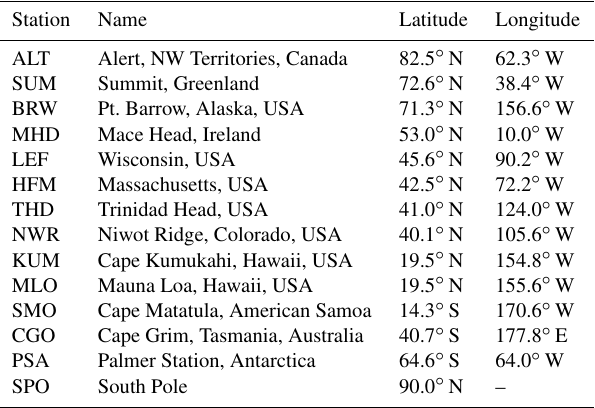
Table 2. Location and code of NOAA/ESRL ground-based stations.